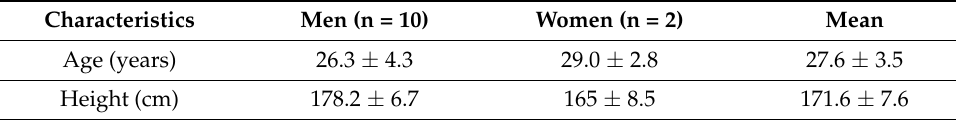
Table 1. Participant